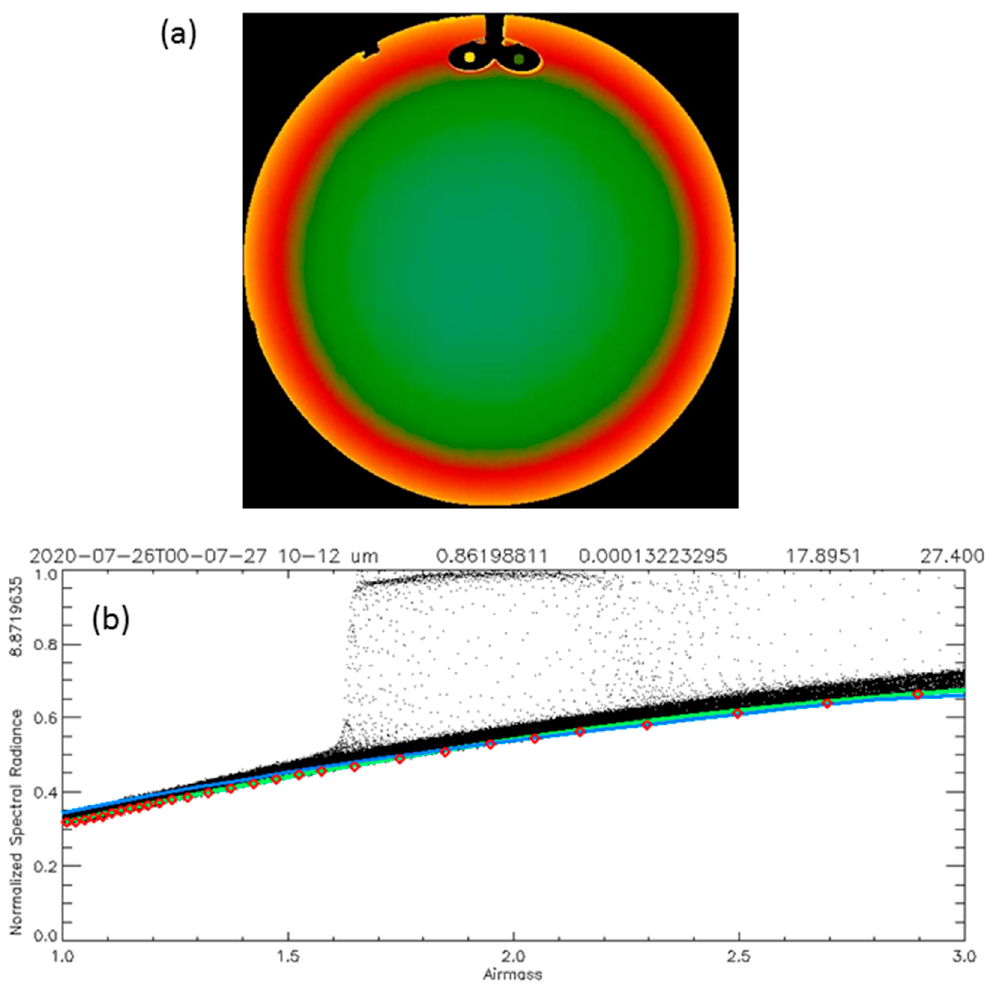
Figure 5. An example of JPEG qualitative images that are produced by the sensor for a quick look at the sky conditions. ( a ) An image of a midsummer clear sky from 26 July 2020 in a color scale of the brightness temperature. The scale runs from yellow-orange-red-green-blue from high to low temperatures respectively. The full-color scale in this image corresponds to a brightness temperatures span of about 230–300 K (red is hot). The non-valid pixels appear in black. The calibration mast with two blackbodies is visually observed on the top of the image. ( b ) A visual graph of the corresponding scatter plot of the brightness temperature (expressed as normalized radiance with respect to ground level temperature) as a function of air mass is used for clear sky estimation. The three-color lines correspond to the different clear sky radiance estimation methods which typically overlap each other at clear sky conditions. It should be noted that these images do not hold quantitative data, and are used only for basic interpretation and for the analysis of the spatial and temporal evolution of the cloud and fog field. The quantitative data were used for obtaining the results depicted in Figures 9–11.